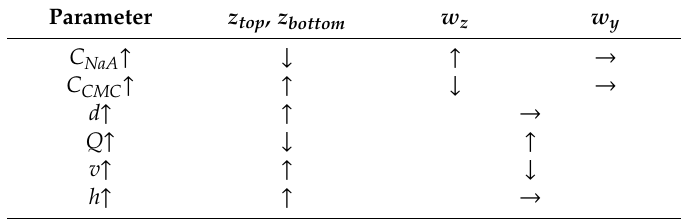
Table 4. Trends of z top , z bottom , w y , and w z under printing parameter